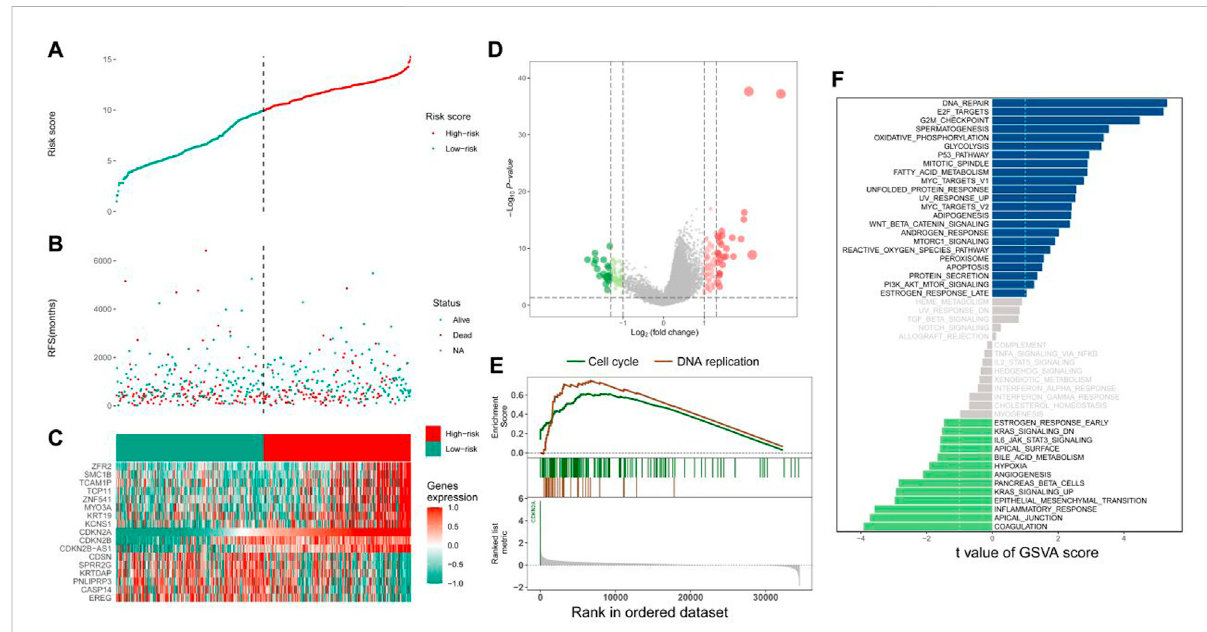
Relevant functions of CDKN2A. (A) Tumour samples in TCGA database were divided into the high- and low-expression groups according to median CDKN2A expression; (B) Scatter plot demonstrating the difference in survival status between the two groups; (C) Top 17 differentially expressed genes; (D) Volcano plot demonstrating the distribution of differentially expressed genes; (E) GSEA; (F) Bar graph demonstrating the differentially enriched pathways between the two